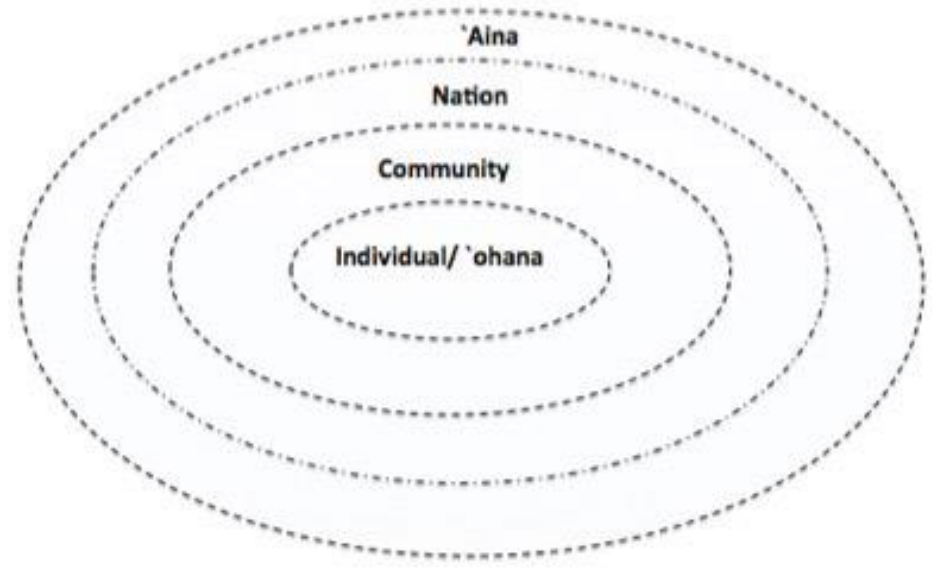
Nik Cristobal, The Ecological Model of Native Hawaiian Well being , Digital Illustration, 2018. 79